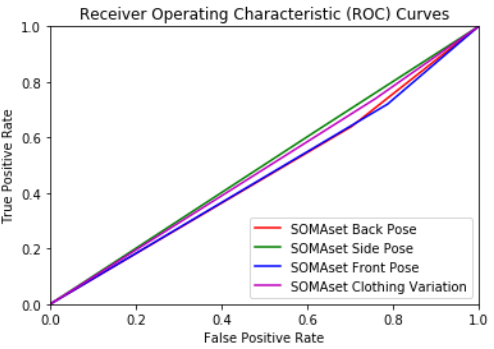
Figure 12. SOMAset dataset ROC curves for different pose and clothing variations as achieved by the Siamese